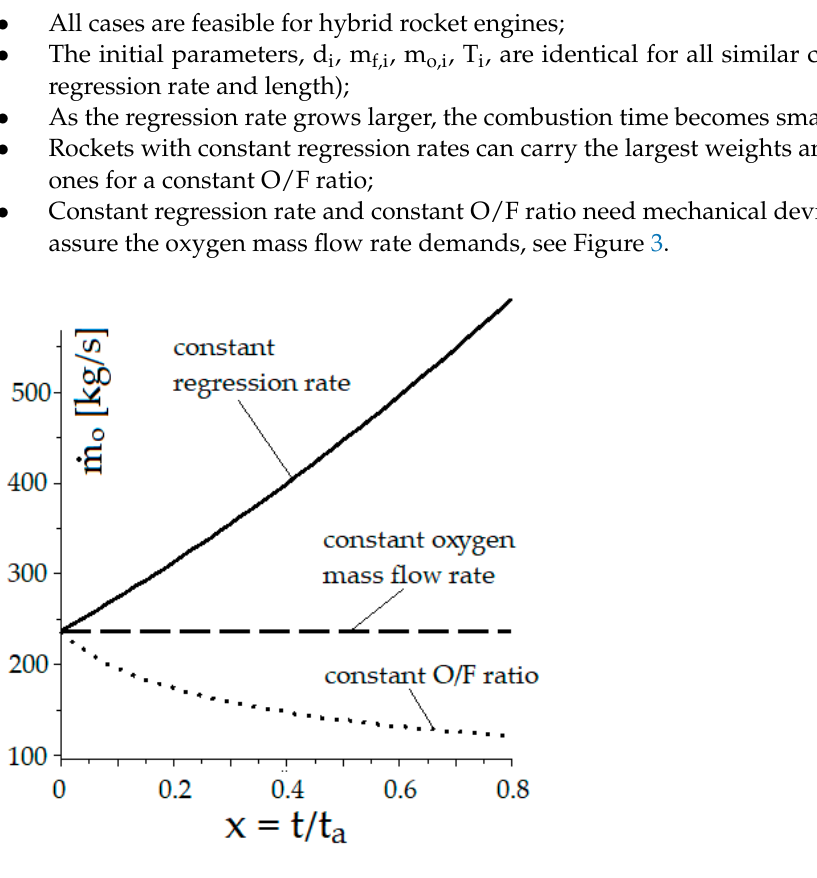
Figure 3. The oxygen mass flow rate during combustion, L = 15 m; R